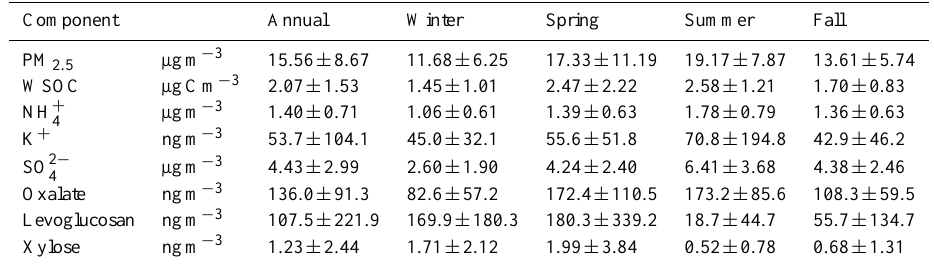
Table 2. Annual and seasonal mean concentrations ( ± STD) of measured PM 2 . 5 components from FRM filters. Winter (J, F, D), Spring (M, A, M), Summer (J, J, A) and Fall (S, O,